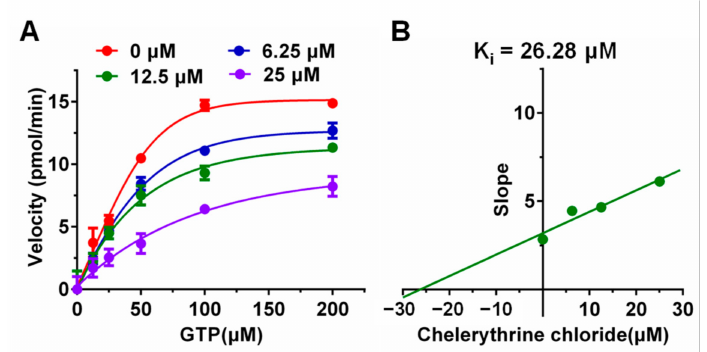
Figure 2. Kinetic study of UreG inhibition by chelerythrine chloride. ( A ) The rates of GTP hydrolysis were plotted as a function of GTP concentrations ranging from 0 to 200 µ M, at different concentrations of chelerythrine chloride (0, 6.25, 12.5, and 25 µ M). Results are desired as means ± SD of triplicate tests. ( B ) The inhibition constant K i was calculated as the intersection on x-axis of the plot of 1/V max versus chelerythrine